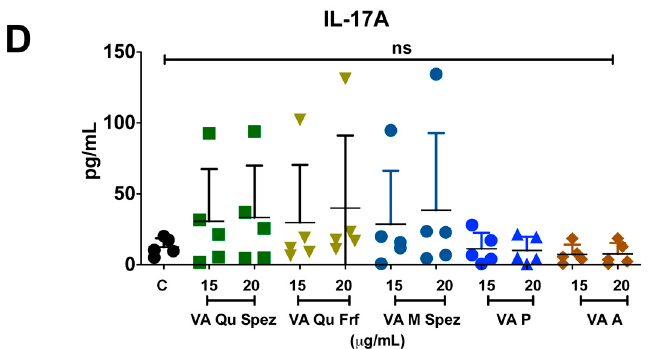
Figure 4. VA Qu Spez-educated DCs significantly induce the secretion of Th1 cytokine IFN- γ in DC-CD4 + T co-cultures. Immature DCs were treated with medium alone (control, labelled as ‘C’) or with five preparations of VA for 48 h. These DCs were co-cultured with CD4 + T cells for five days. Amount (pg/mL, mean ± SEM, five independent donors) of secretion of ( A ) IFN- γ ; ( B ) IL-4; ( C ) IL-13; and ( D ) IL-17A in the cell-free supernatants from the above co-cultures was presented. * p < 0.05.